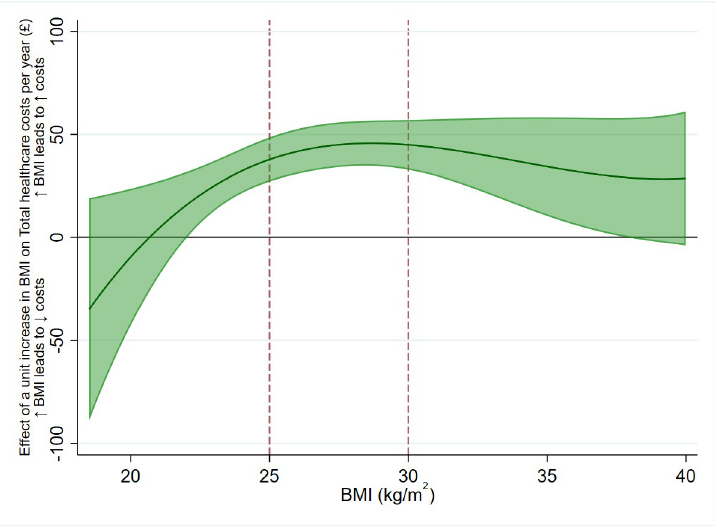
Fig 5. The effect of 1-kg/m 2 increase in BMI on total healthcare costs per year, across BMI levels. A positive value indicates that an increase in BMI would increase total healthcare costs, and vice versa. Due to the uncertainty in the estimates, there is little statistical evidence of nonlinearity in the effect of BMI on total healthcare costs, though descriptively, it appears that a 1-kg/m 2 increase in BMI has a smaller effect on costs in the normal weight category, and a larger effect in overweight and obesity. The BMI thresholds of 25 kg/m 2 (overweight) and 30 kg/m 2 (obese) are represented with dashed red lines. The green shaded area represents the 95% CI of the estimated effect. Effect estimates are derived from the nonlinear imputation model. BMI, body mass index; CI, confidence